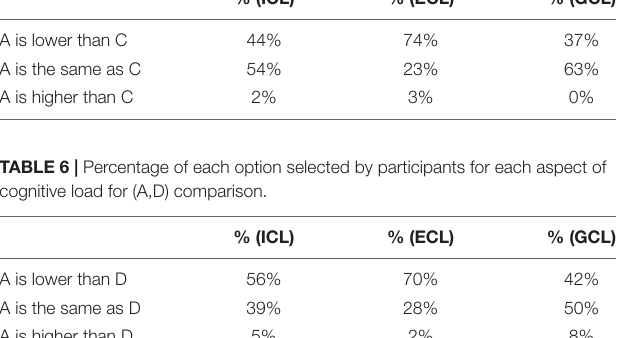
TABLE 5 | Percentage of each option selected by participants for each aspect of cognitive load for (A,C) comparison. % (ICL) % (ECL) % (GCL)